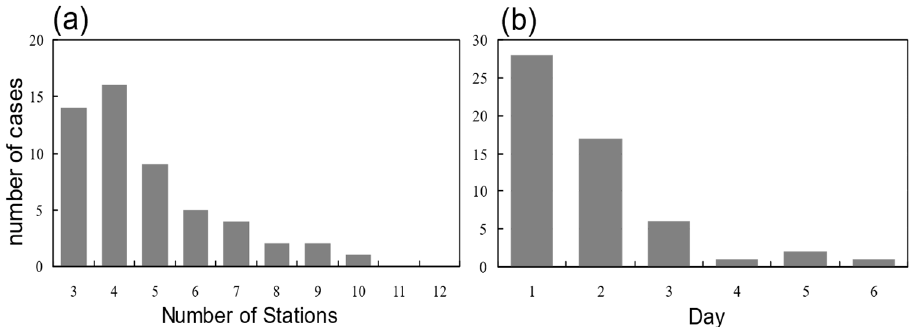
Figure 5. The number of cases of REP events versus the number of stations ( a ) and the persistence days ( b ).